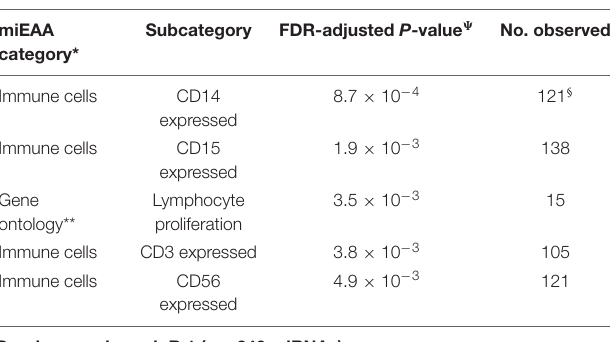
TABLE 5 | Top-5 MSEA results for miRNAs representing dendrogram branches A.1 and B.1. Dendrogram branch A.1 ( n = 250